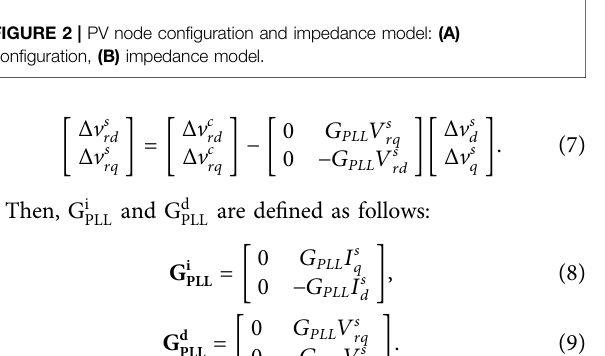
FIGURE 2 | PV node con fi guration and impedance model: (A) con fi guration, (B) impedance